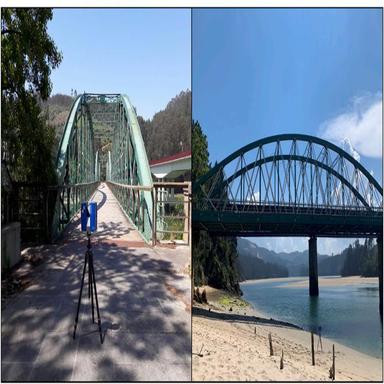
Geometry data acquisition using Terrestrial Laser Scanner (TLS) technology.